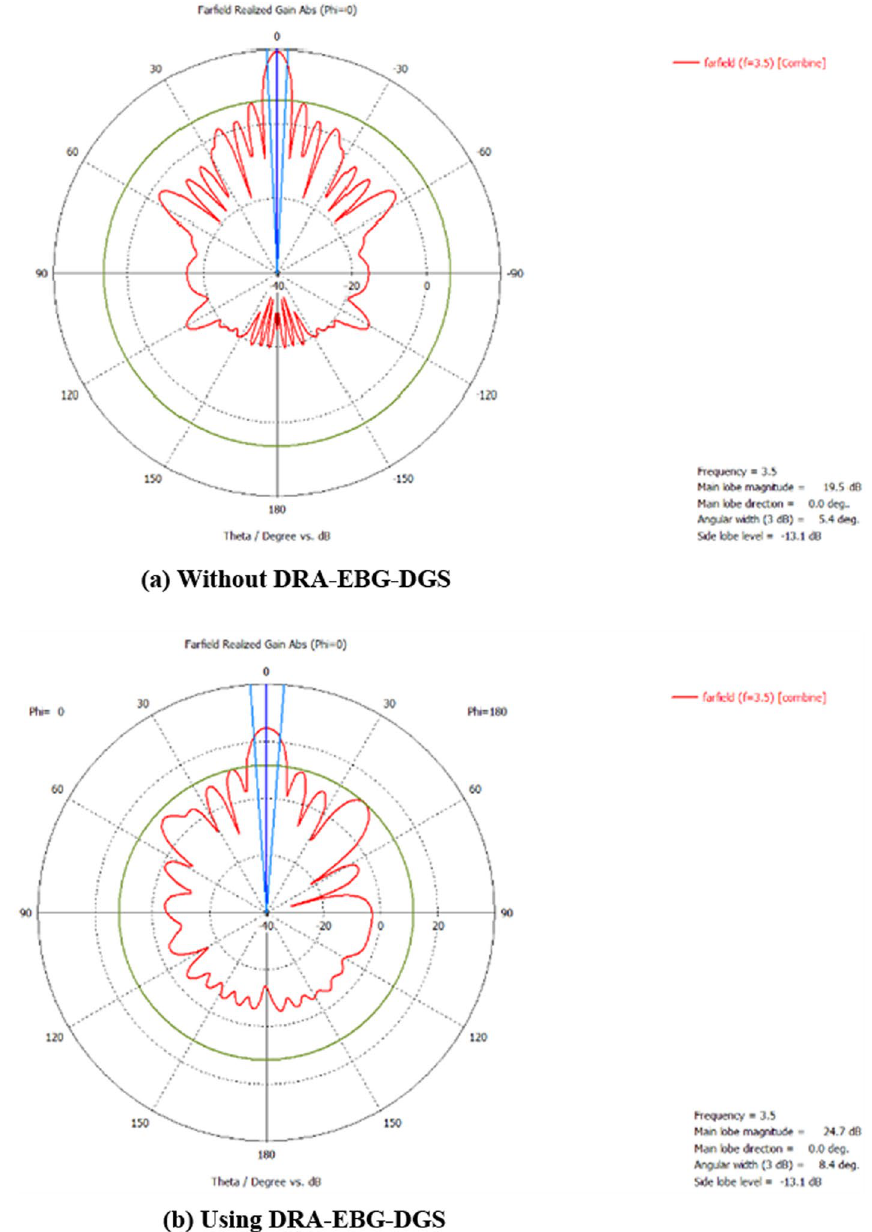
Fig. 9 Simulation result of 360° radiation